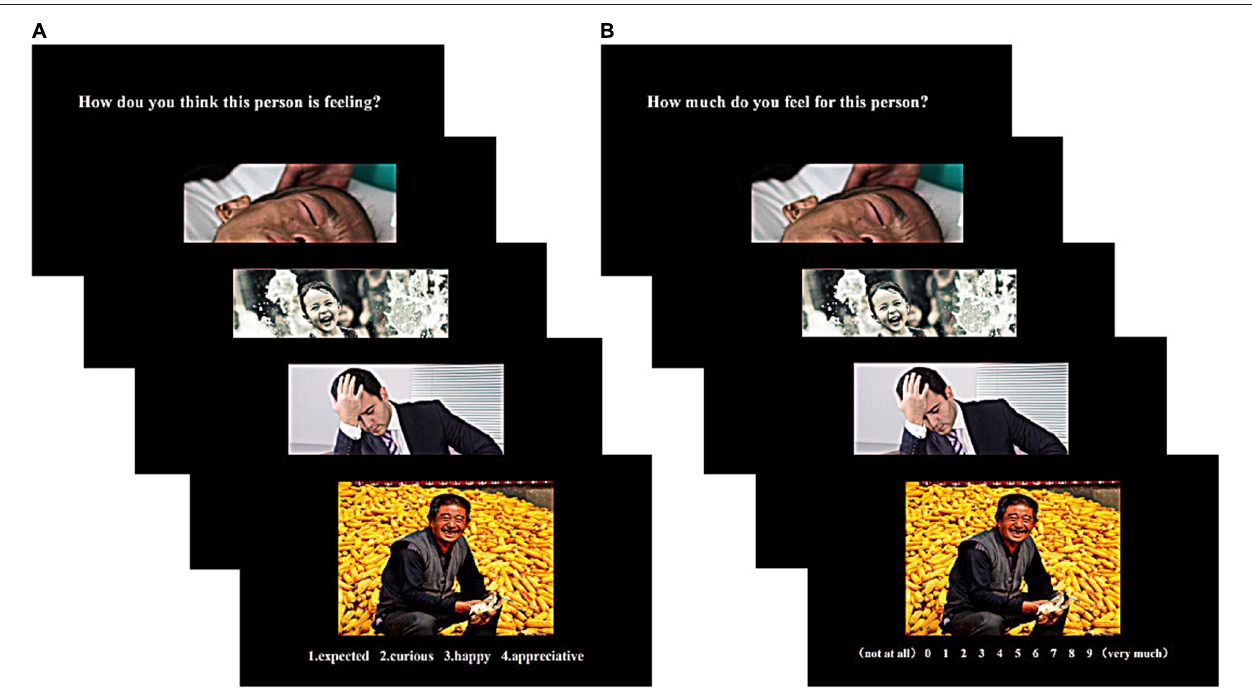
FIGURE 1 | Tasks for measuring cognitive empathy (A) and emotional empathy (B) . Stimuli were presented in blocks of 10. Each block was introduced with a question indicating the block